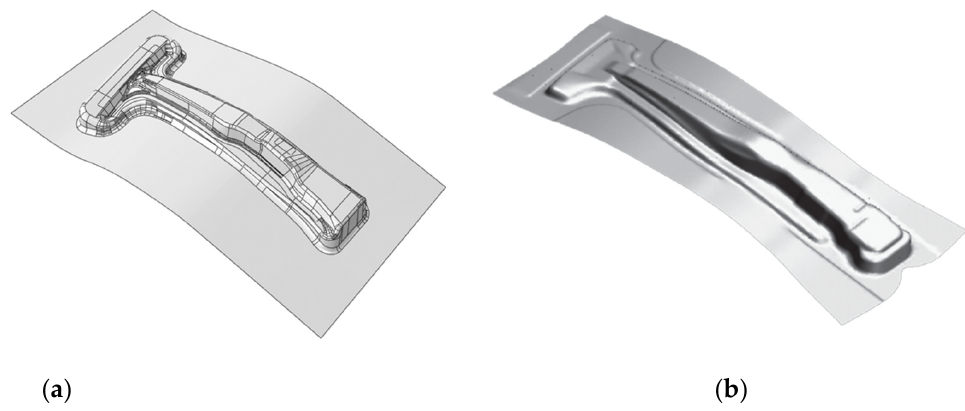
Figure 7. ( a ) CAD model of the die for B ‐ pillar part and ( b ) an example of the formed product.